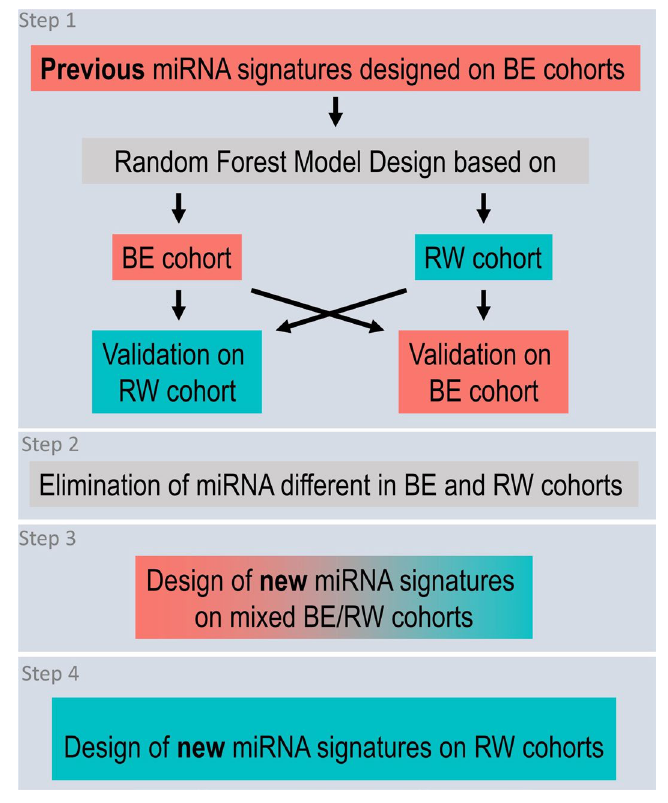
Figure 1. Overview of the major steps of the